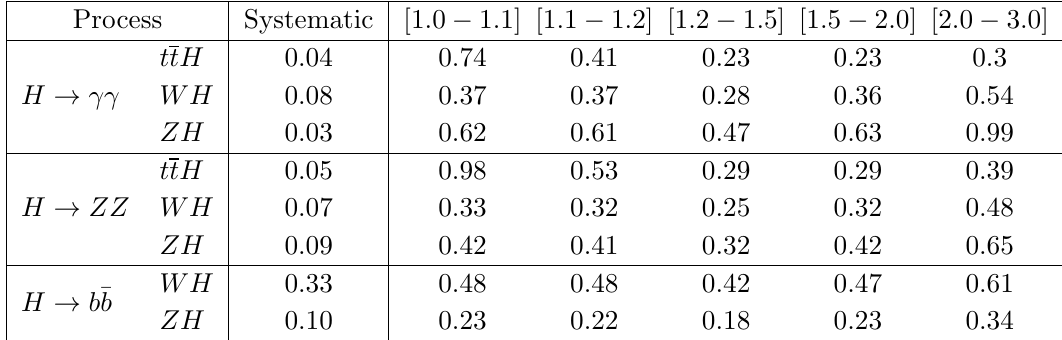
Table 7 . Estimated relative uncertainties on the determination of the di(cid:11)erential distributions in the associated Higgs production channels. These estimates correspond to the ‘optimistic’ scenario in which the systematic uncertainties are assumed to be the same for each bin and only the statistical uncertainty is rescaled according to the number of events in each bin.